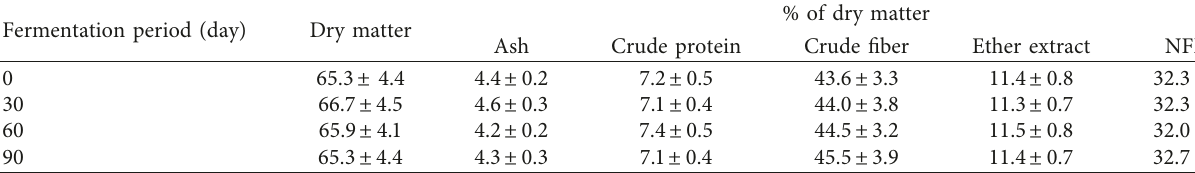
Table 1: Chemical composition of olive cake during 90 days of fermentation.